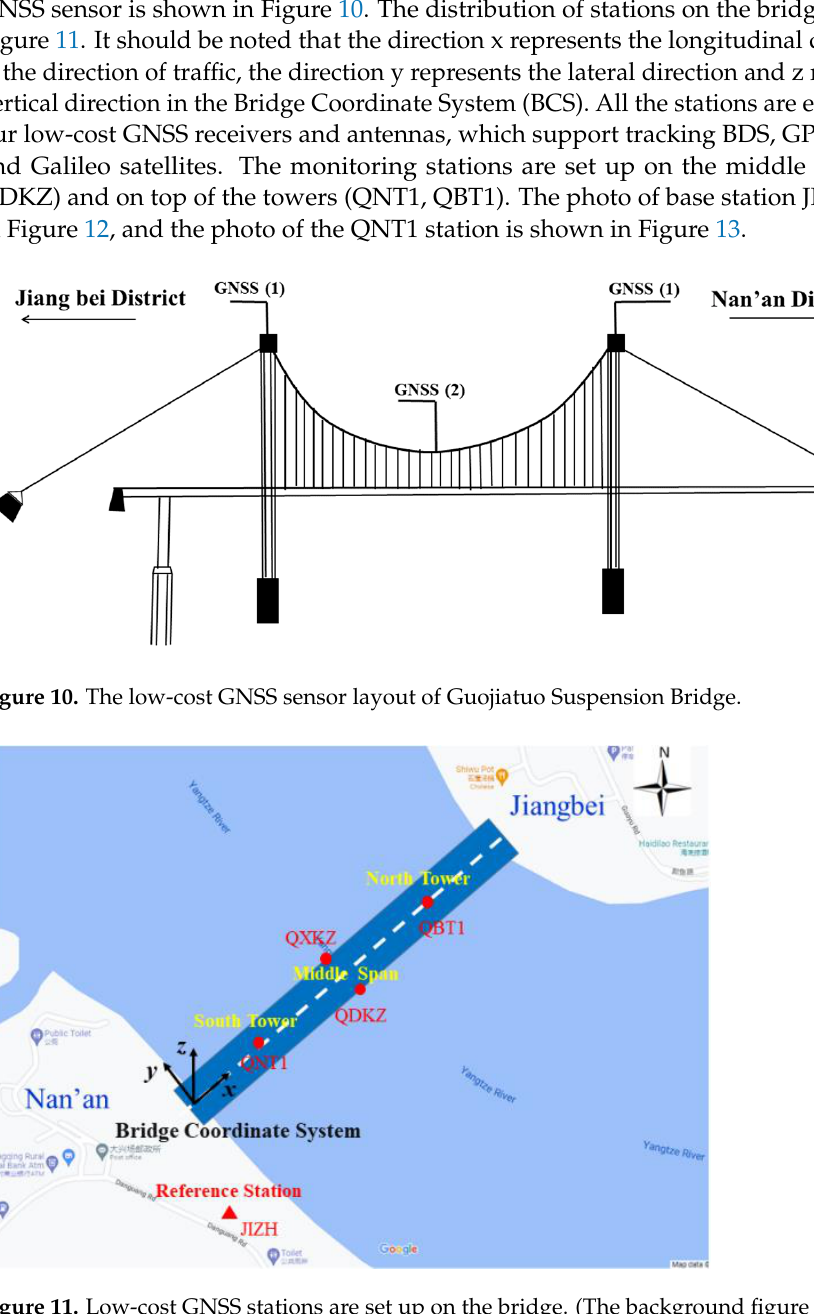
Figure 12. GNSS reference station JIZH. Figure 13. GNSS monitoring station QNT1. 3.2.2. Multi-GNSS Integration Positioning Method In general, the GNSS satellite transfers pseudo-range and carrier phase signals for positioning,